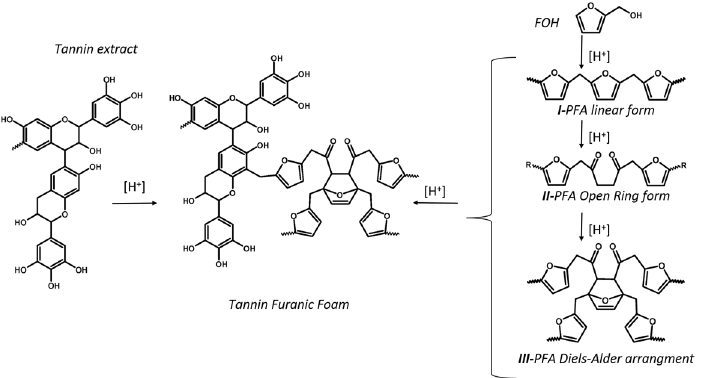
Figure 1. Acid-catalyzed copolymerization of tannin extract and FOH in acid environment to tannin-furanic foam. The most probable homopolymerization pathways of FOH to PFA are reported: I-PFA linear aliphatic structure, II-PFA γ -diketonic Ring-open structure, III-Diels-Alder rearrangement of I and